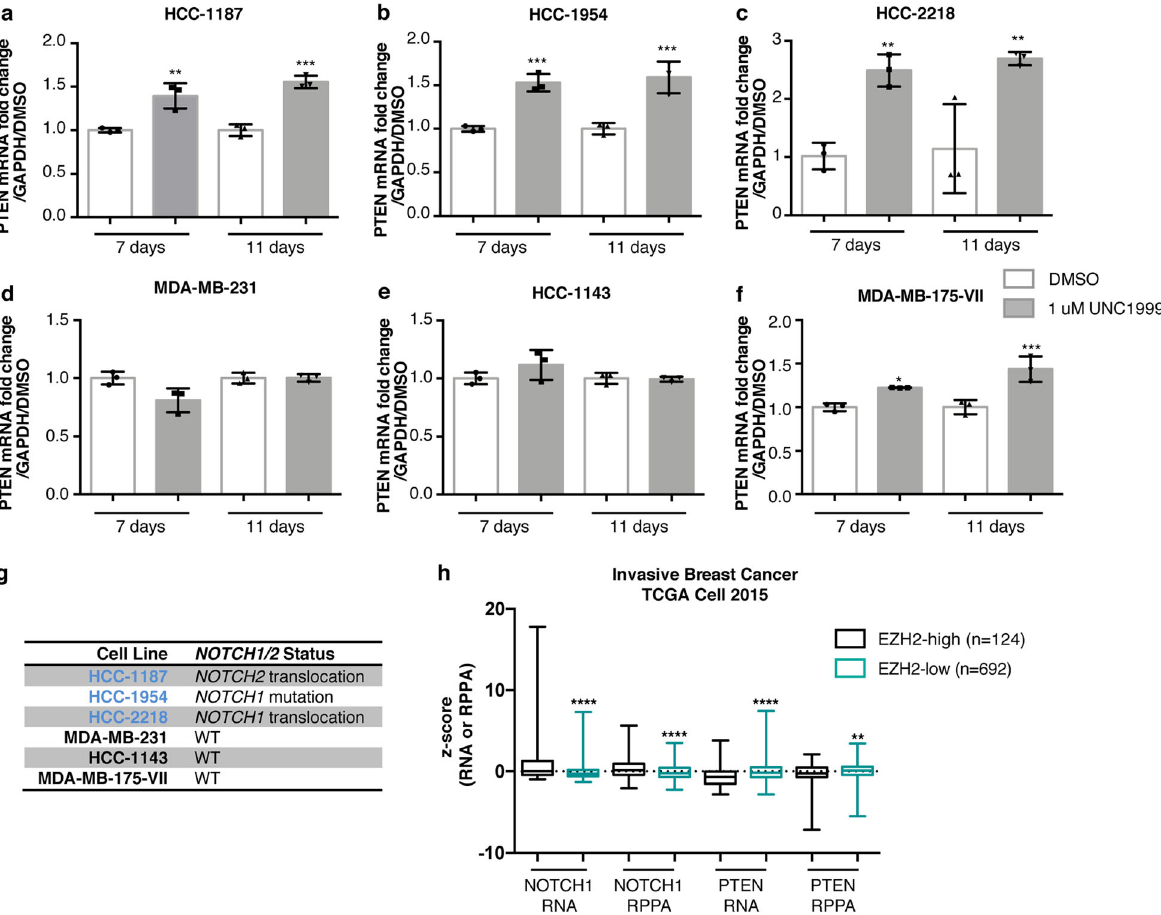
Fig. 4 Mutation of NOTCH1/2 enhances restoration of PTEN expression in response to EZH2 inhibition. Inhibition of EZH2 by UNC1999 was performed for 7 days and 11 days and transcript levels of PTEN were measured by qRT-PCR in ( a ) HCC-1187, ( b ) HCC-1954, ( c ) HCC-2218, ( d ) MDA-MB-231, ( e ) HCC-1143, and ( f ) MDA-MB-175-VII. Error bars: mean ± s.d., triplicate measurements. Signi fi cance from Ctrl: one-way ANOVA, Sidak ’ s correction. g Table shows the NOTCH1/NOTCH2 mutation status of breast cancer cell lines 32,40 . h Boxplots of NOTCH1 and PTEN RNA and protein levels in EZH2- high (RNA-seq z -score > 1) and EZH2-low (RNA-seq z -score < 1) breast cancer cases, measured by RNA-seq and RPPA, respectively 34 . Number of cases indicated for each group (total n = 816). (**** P < 0.0001; *** P < 0.001; ** P < 0.01; * P <